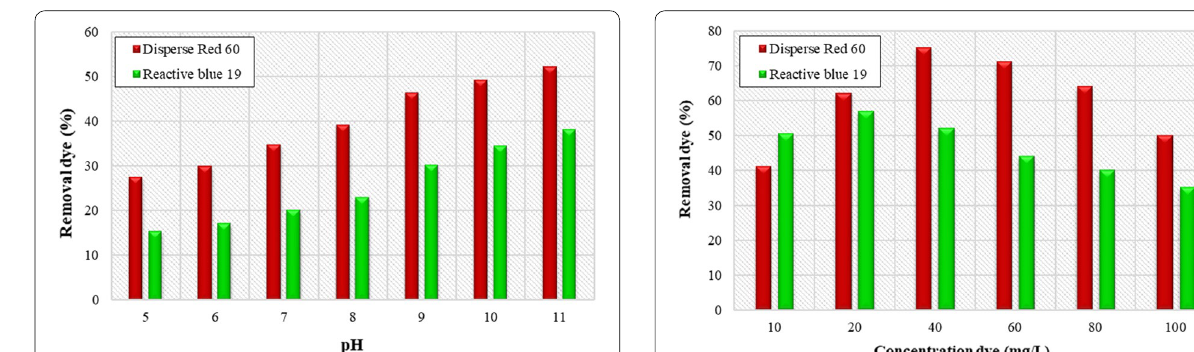
100 mg/L; initial dye =